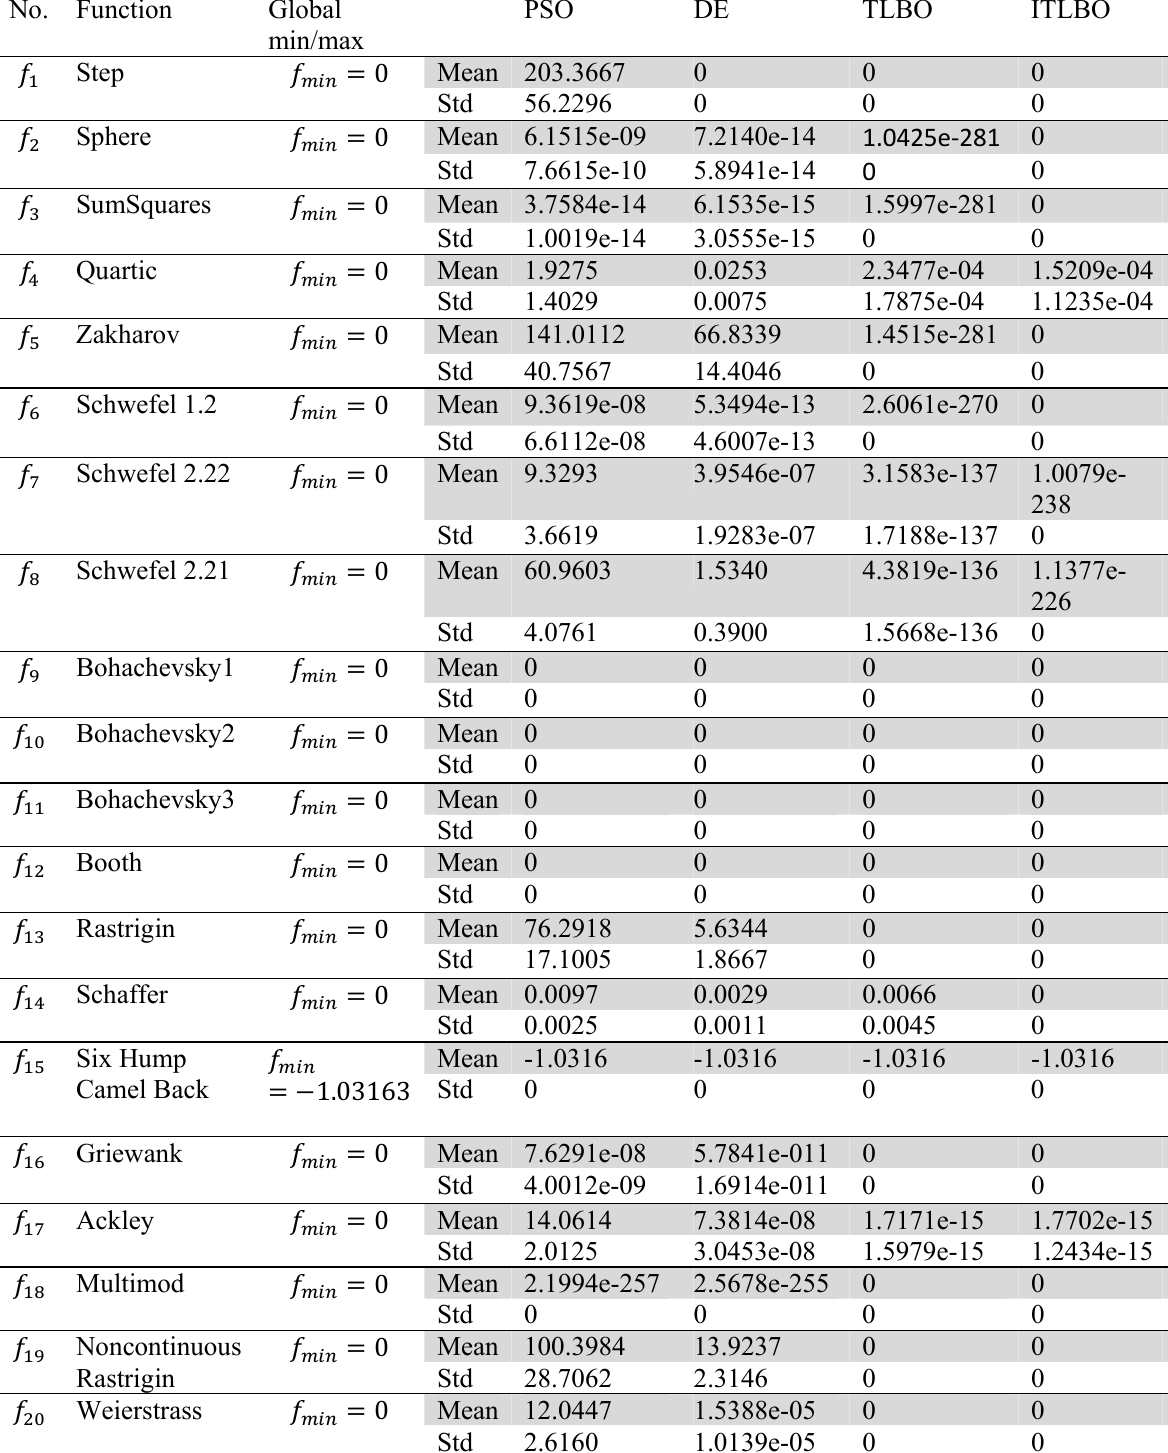
Performance comparisons of PSO, DE, TLBO, ITLBO No.